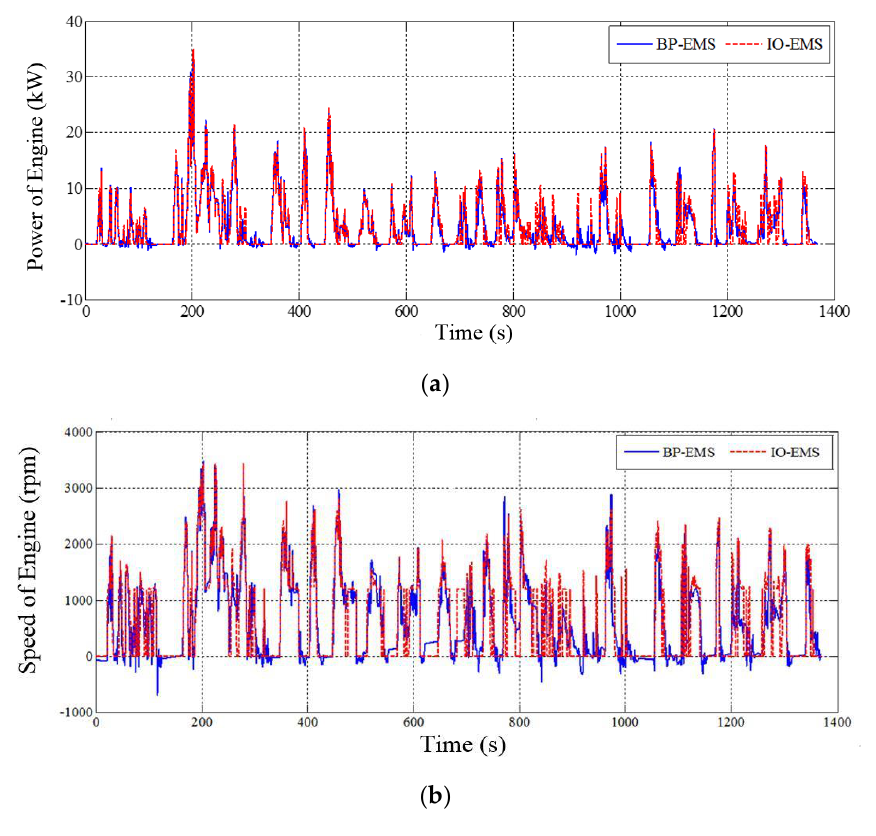
Figure 12. Power ( a ) and speed ( b ) of ICE during UDDS driving cycle.